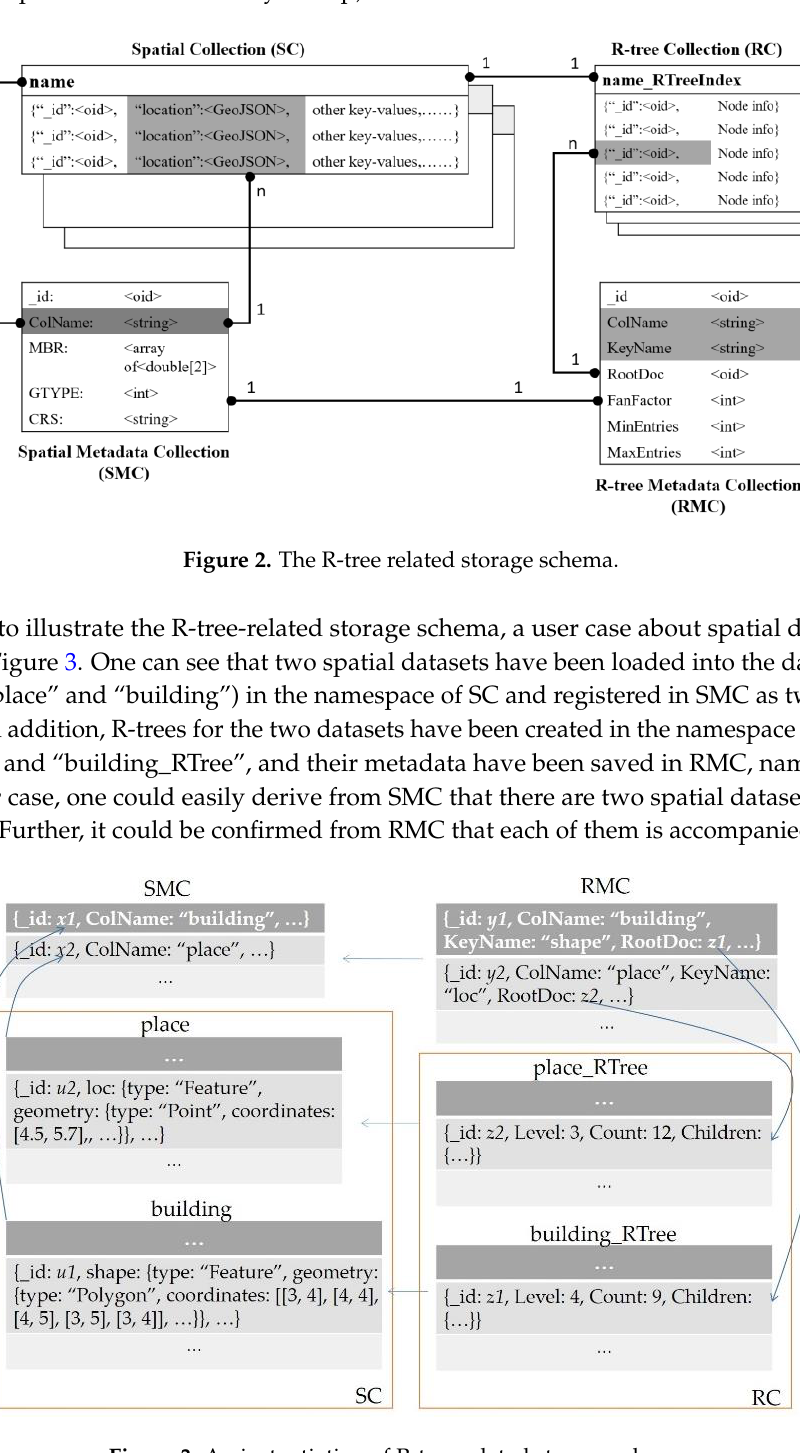
Figure 3. An instantiation of R-tree related storage schema.